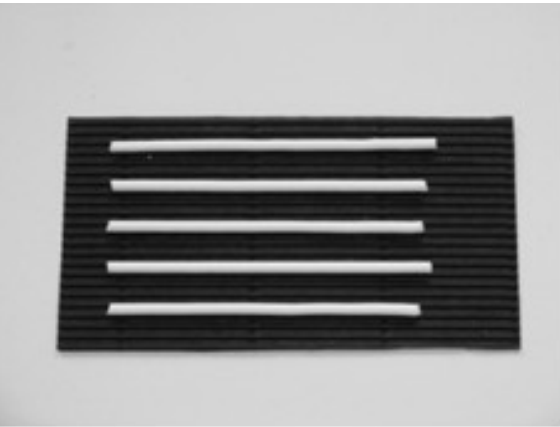
Figure 1. Dried effervescent strands (3 mm in diameter, approximately 5 cm length) obtained by twin-screw